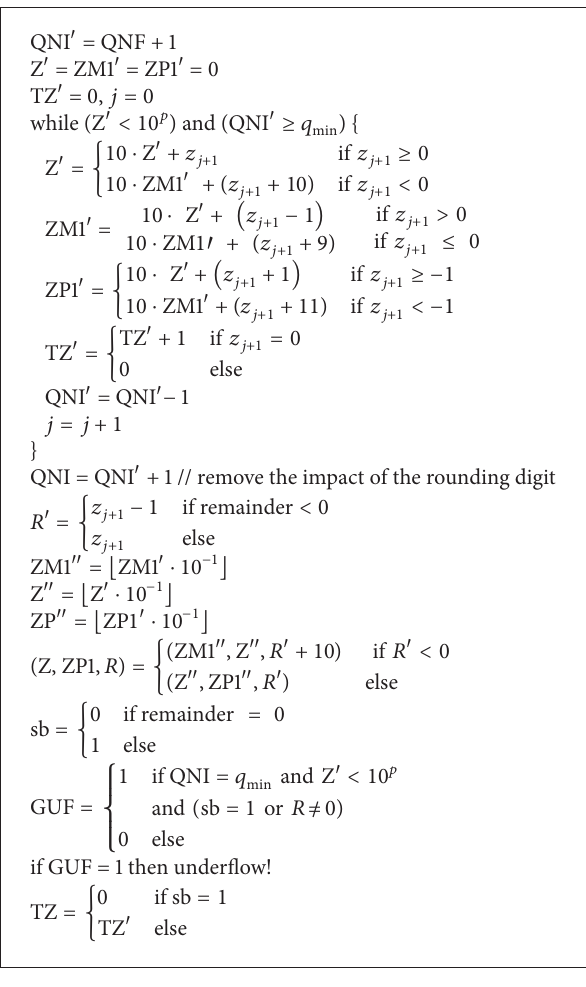
final remainder is less than zero. The sticky bit (sb) is used for rounding and is asserted high whenever the remainder is unequal to zero.